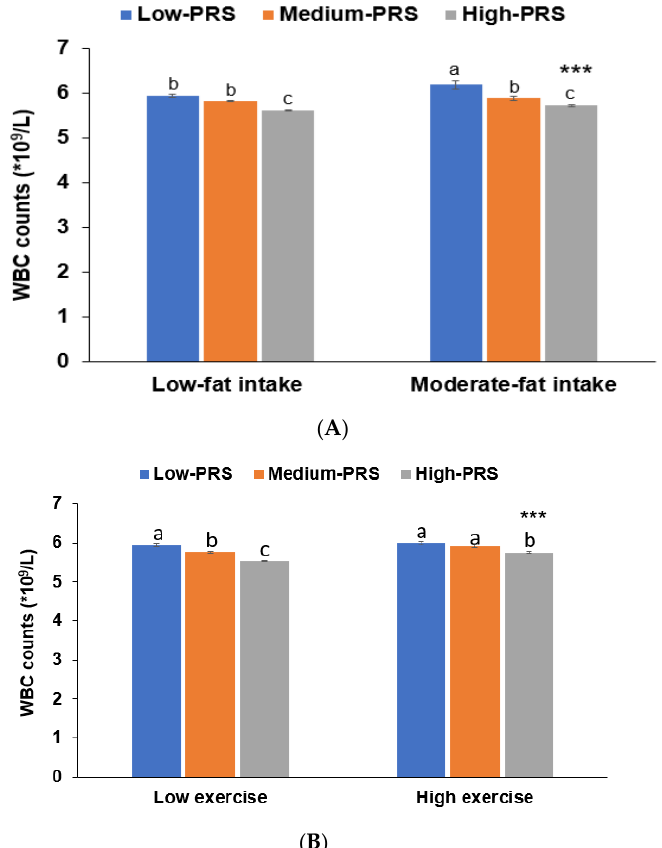
Figure 3. Adjusted means and standard errors of white blood cell counts among 7-SNP polygenetic risk scores (PRS) according to low and high groups of fat intake and exercise. ( A ). Adjusted means and standard errors of WBC in the participants were categorized by fat intake (cutoff value: 20 energy % of fat intake). ( B ). Adjusted means and standard errors of participants categorized by exercise (cutoff: moderate-intensity exercise at least for 30 min three times weekly). *** Significantly different between those with low and high-PRS in ANCOVA at p < 0.001. a,b,c Different alphabetical letters on the bar indicate significant differences among the groups in Tukey’s test at p < 0.05.